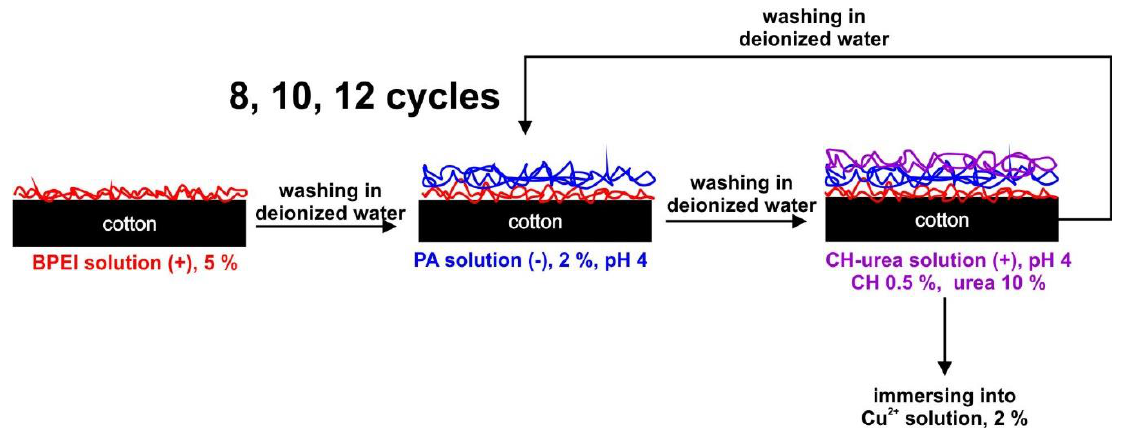
Figure 1. The LbL deposition process of FR/antimicrobial nanocoating on cotton.